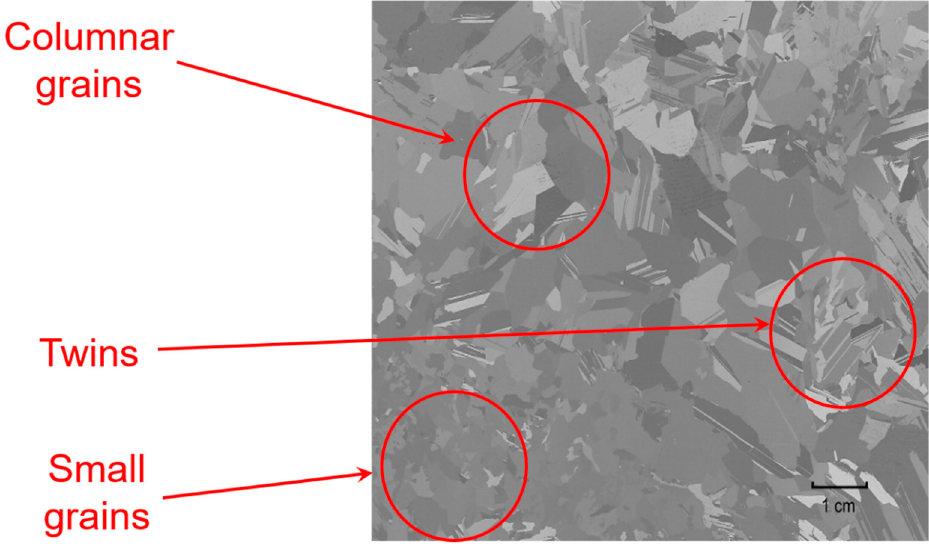
Figure 5. Grain structure of a Si solar cell wafer.